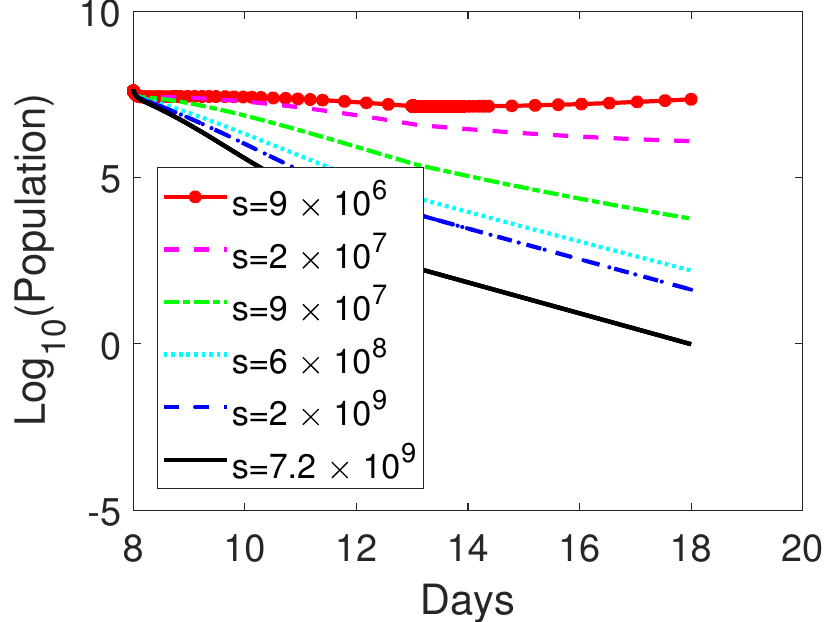
Figure 3. Comparison among numerically simulated dynamics of susceptible tumor cells for OV- aCTLA-4 treatment on day 18 post-implementation with various amounts of oncolytic virus. The initial condition is as in Figure 2. The level of oncolytic virus is represented by s as indicated in the figure. The treatment started on day 8 post-implantation as the tumor size reaches 4 × 10 7 and lasted for 5 days. The same CTLA-4 blocking rate as in Figure 2, u = 0.76, is applied to OV-aCTLA-4 treatment. Other parameter values are listed in Table